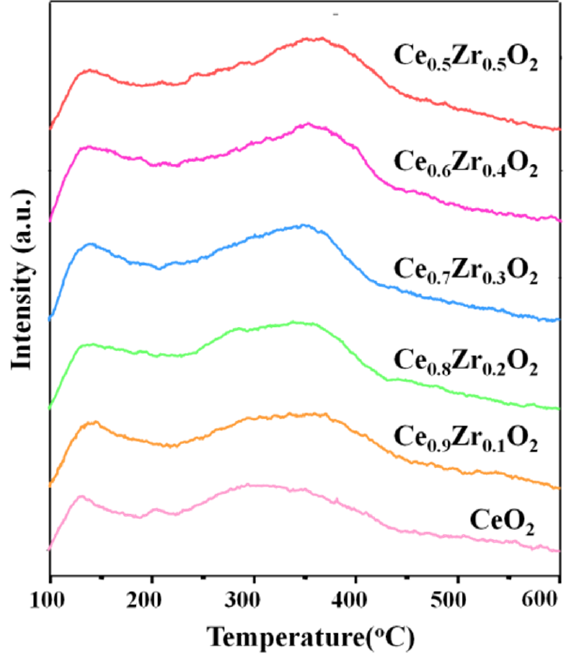
Figure 4. CO 2 -TPD profiles of Ce 1-x Zr x O 2 nanorods.